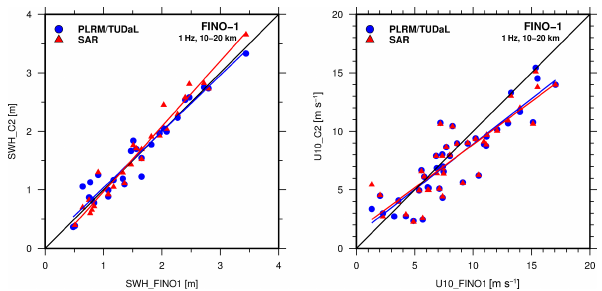
Figure 5. Comparison at station FINO-1 of in situ and altimeter- derived (a) significant wave height and (b) wind speed of in situ and co-located altimeter measurements at the FINO-1 station. Altimeter data are SAR (triangle) and PLRM (circle).